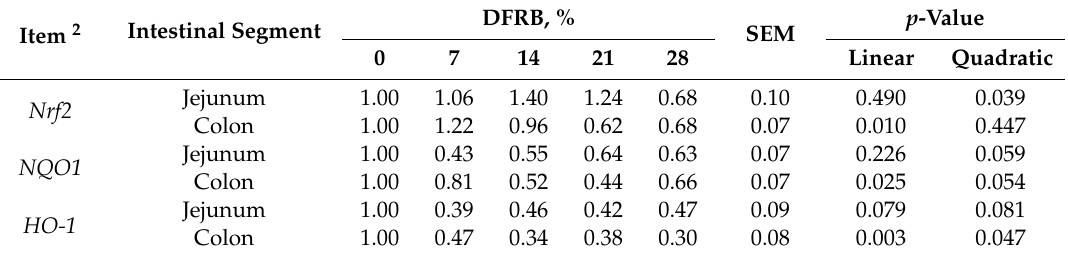
Table 9. E ff ects of increasing DFRB supplementation on Nrf2 , NQO1 , and HO-1 in jejunum and colon of finishing pigs 1